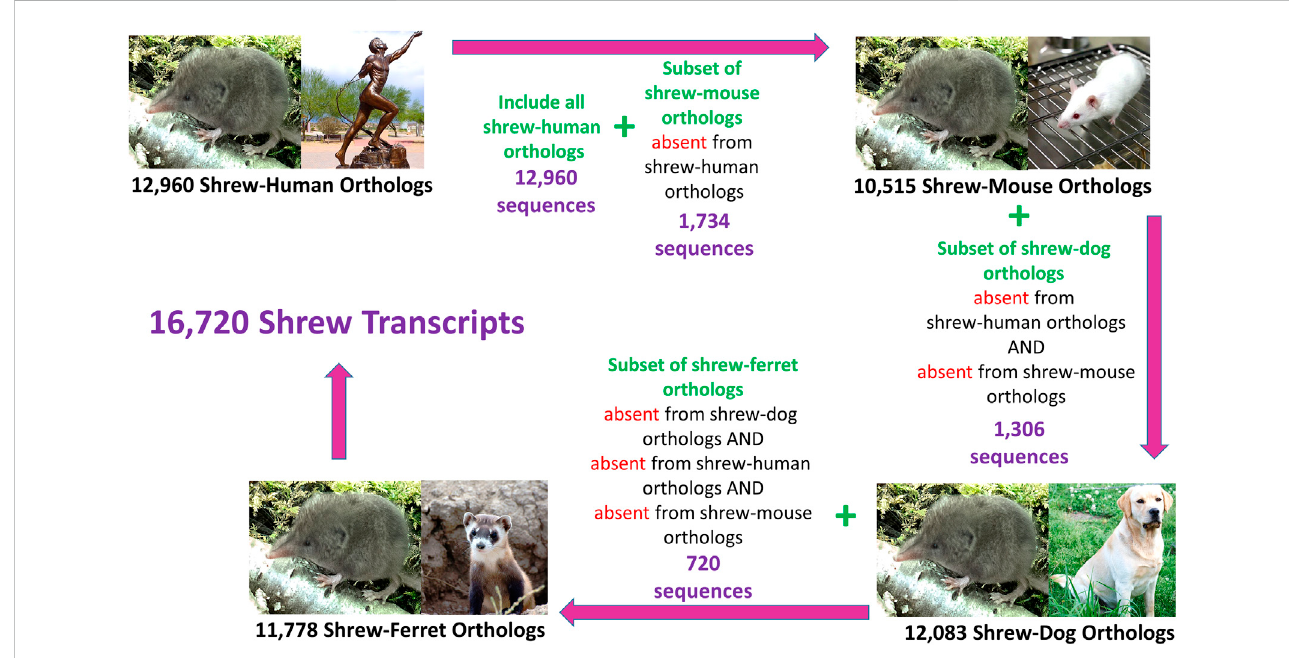
FIGURE 2 Conceptual strategy for identifying Non-Redundant Orthologs Across Species. One to one orthologs between the least shrew transcript sequences and otherspeciesranged from10,515(mouse) to12,965(human).Sometranscripts wereidenti fi edinonespecies,butnotintheotherspecies,acumulativesetof shrew transcripts containing 16,720 sequences was compiled that represents the greatest number of shrew orthologues from the four species. Another set, called “ shared ” transcripts (7,339) was extracted which contained a one-to-one orthologue from each of the four species. Images of each species